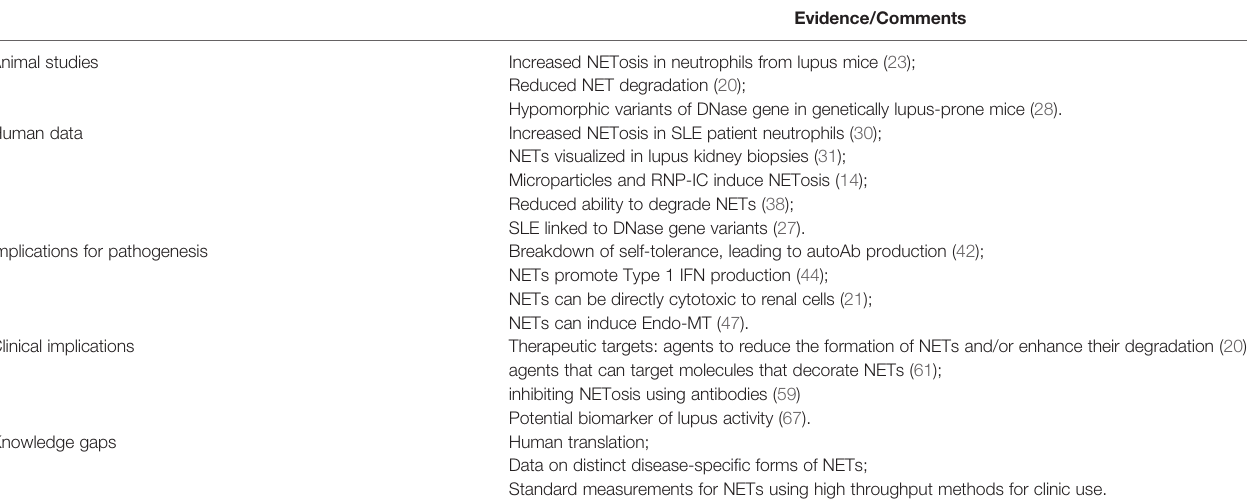
TABLE 1 | Overview on the role of NETosis in the pathogenesis of